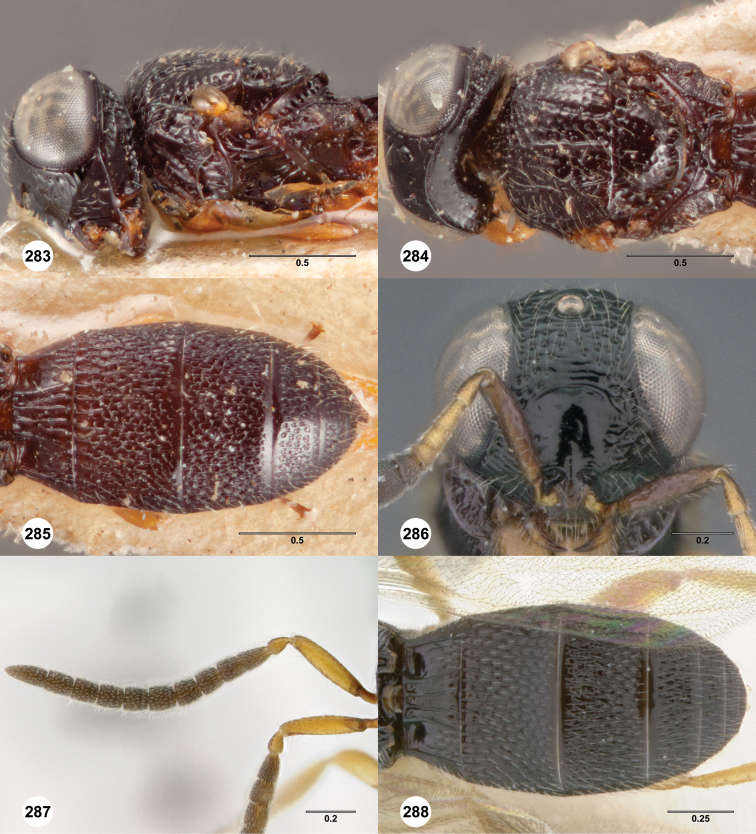
Oxyscelio rugulosus (Dodd), syntype female (SAMA DB 32-001590) 283 Head and mesosoma, lateral view 284 Head and mesosoma, dorsal view 285 Metasoma, dorsal view. Female (OSUC 442410) 286 Head, anterior view. Male (OSUC 442459) 287 Antenna 288 Metasoma, dorsal view. Morphbank82